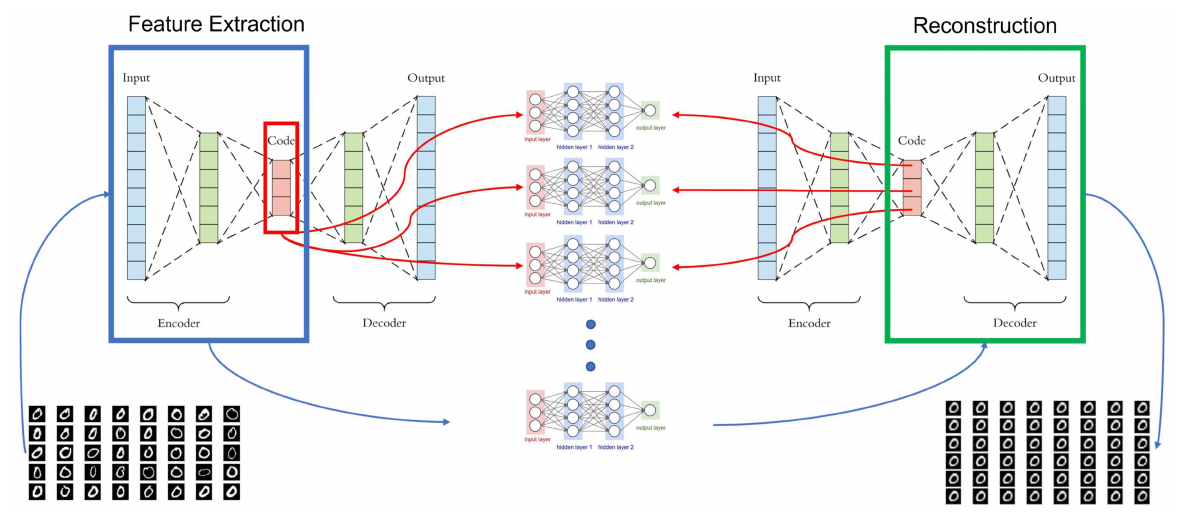
Figure 1. Architecture of the proposed